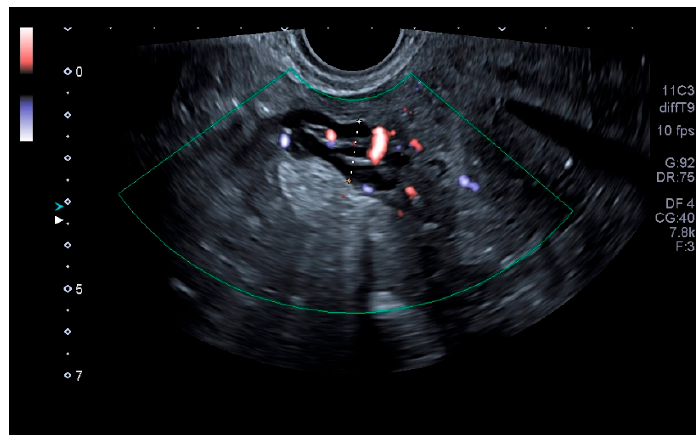
Figure 3. Largest venous plexus diameter measurement.